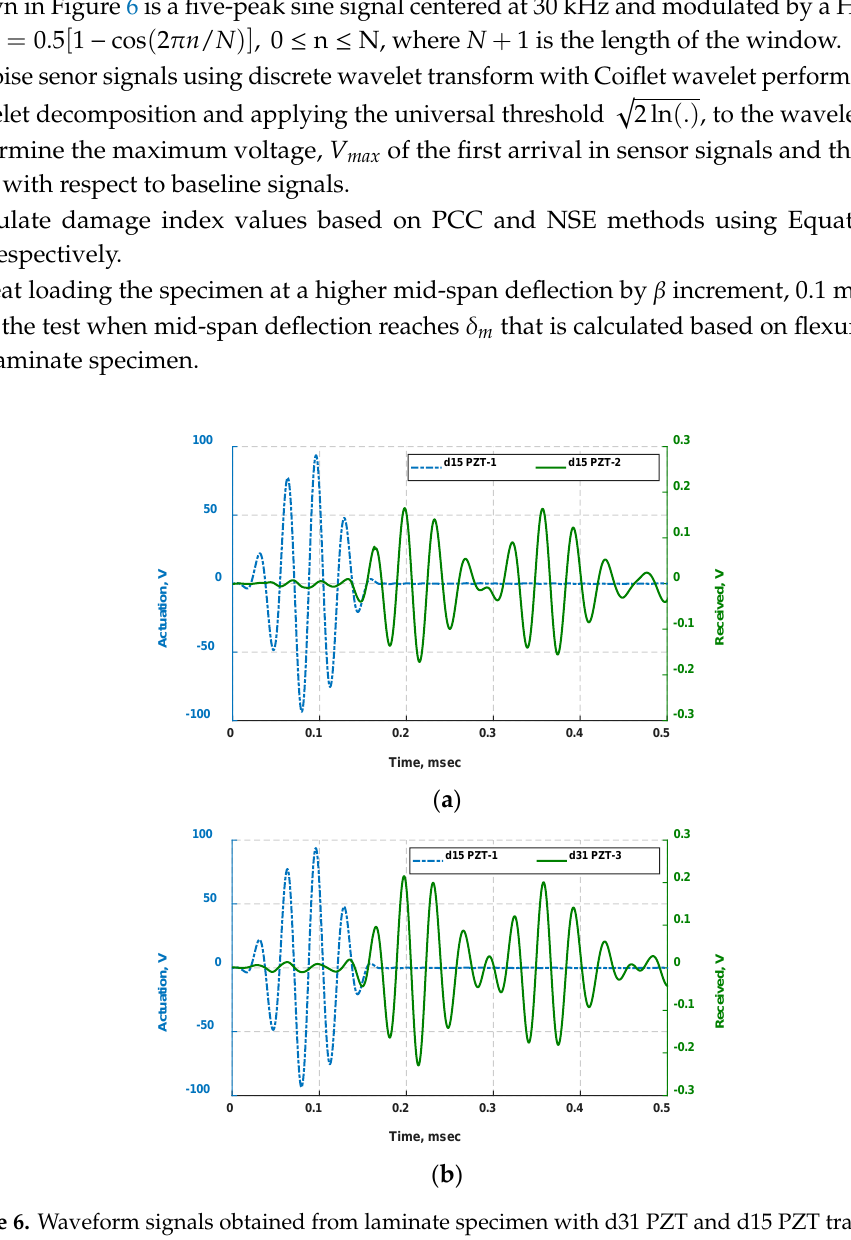
Figure 6. Waveform signals obtained from laminate specimen with d31 PZT and d15 PZT transducers for wave propagation paths: ( a ) PZT-1 → PZT-2 and ( b ) PZT-1 → PZT-3.